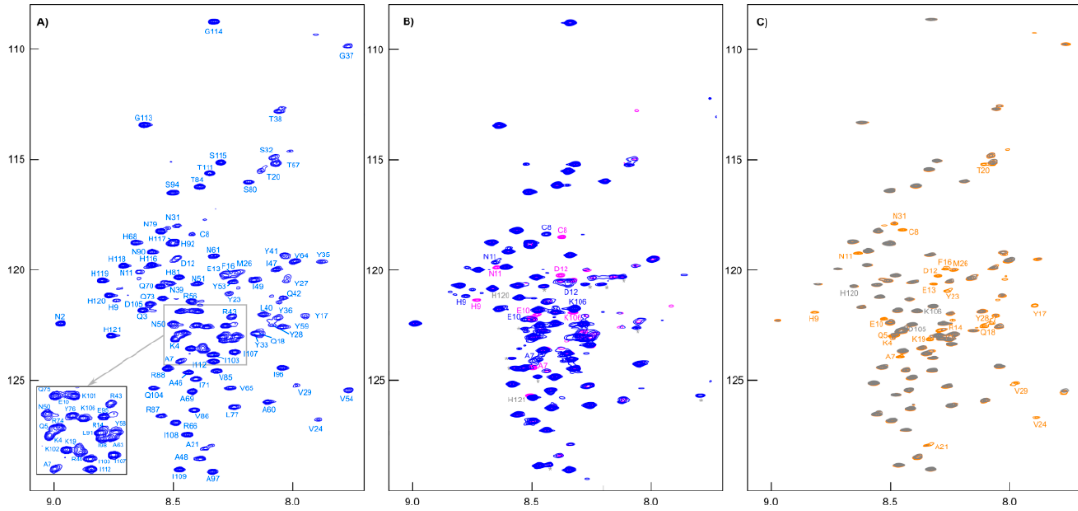
Figure 6. ( A ) The 1 H- 15 N HSQC spectrum of [U- 13 C, 15 N]-RL2 (~1 mM, pH 3.5). ( B ) Overlapping 1 H- 15 N HSQC spectra of [U- 13 C, 15 N]-RL2 (~1 mM, acetate buffer, pH 3.9) before (blue peaks) and after (pink peaks) addition of TCEP (an asterisk indicates peaks of impurities). ( C ) Overlapping 1 H- 15 N HSQC spectra of MTSL-[U- 15 N]-RL2 (~0.1 mM, acetate buffer, pH 3.9) before (gray peaks) and after addition (orange peaks) of ascorbic acid.